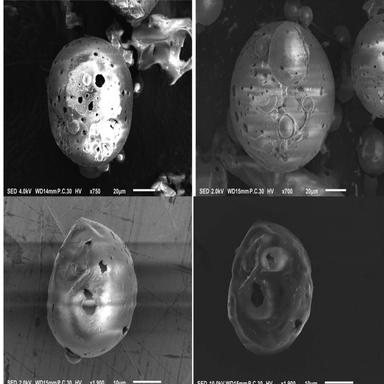
SEM images of the pure HP-β-CyD.